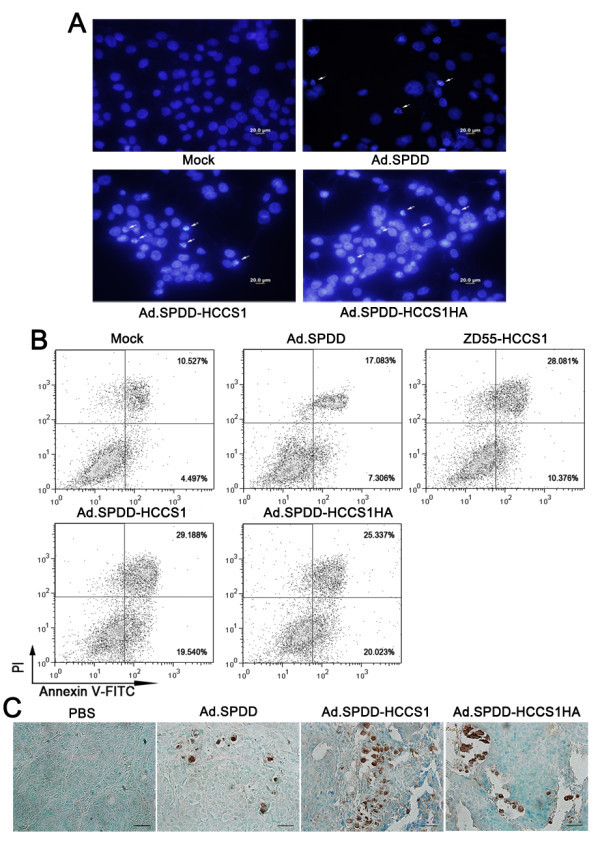
Ad.SPDD-HCCS1 can induce apoptosis of hepatocellular carcinoma cells both in vitro and in vivo. (A) Ad.SPDD-HCCS1 and Ad.SPDD-HCCS1HA induce more nuclear condensation than Ad.SPDD. Hoechst33258 staining was performed on Huh-7 cells 48 hours after infection with viruses at an MOI of 10. Scale bar = 20 μm. (B) Annexin V-FITC/PI staining FACS assay. The percentages of the cells in the second and fourth quadrants are shown. (C) Detection of apoptosis in tumor sections by TUNEL staining. Scale bar = 100 μm.